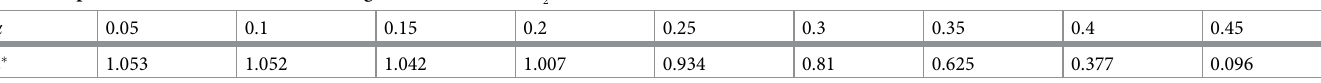
Table 8. Optimal value of a in the Poisson-Lognormal case for a < 1